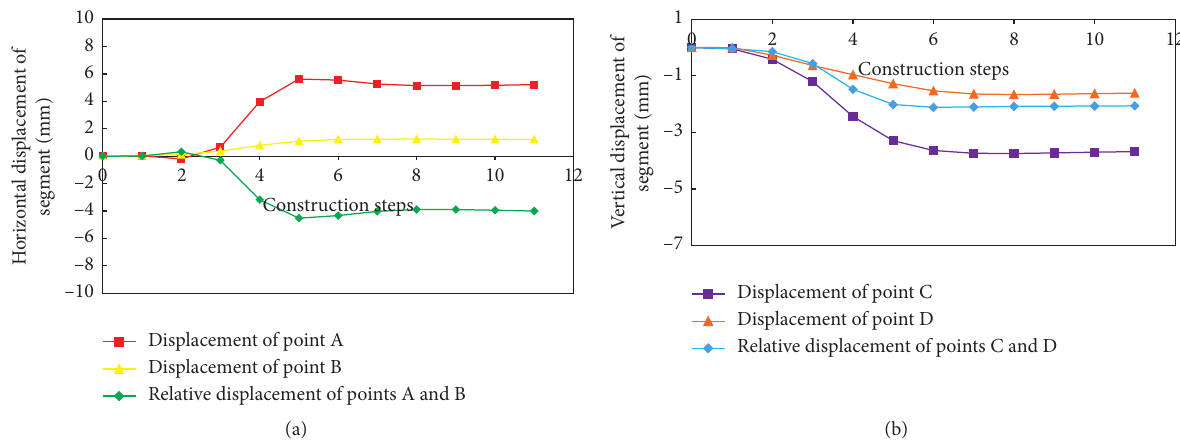
Figure 15: Displacement curve of the 132nd ring segment in the construction processes of left tunnel excavation. (a) Horizontal dis- placement curves of points A and B. (b) Vertical displacement curve of points C and D.